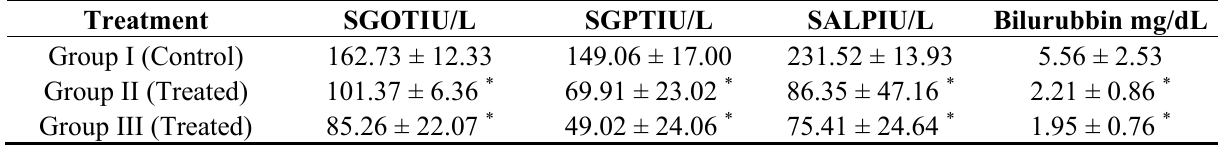
Table 3. Effect of rutinon serum enzyme